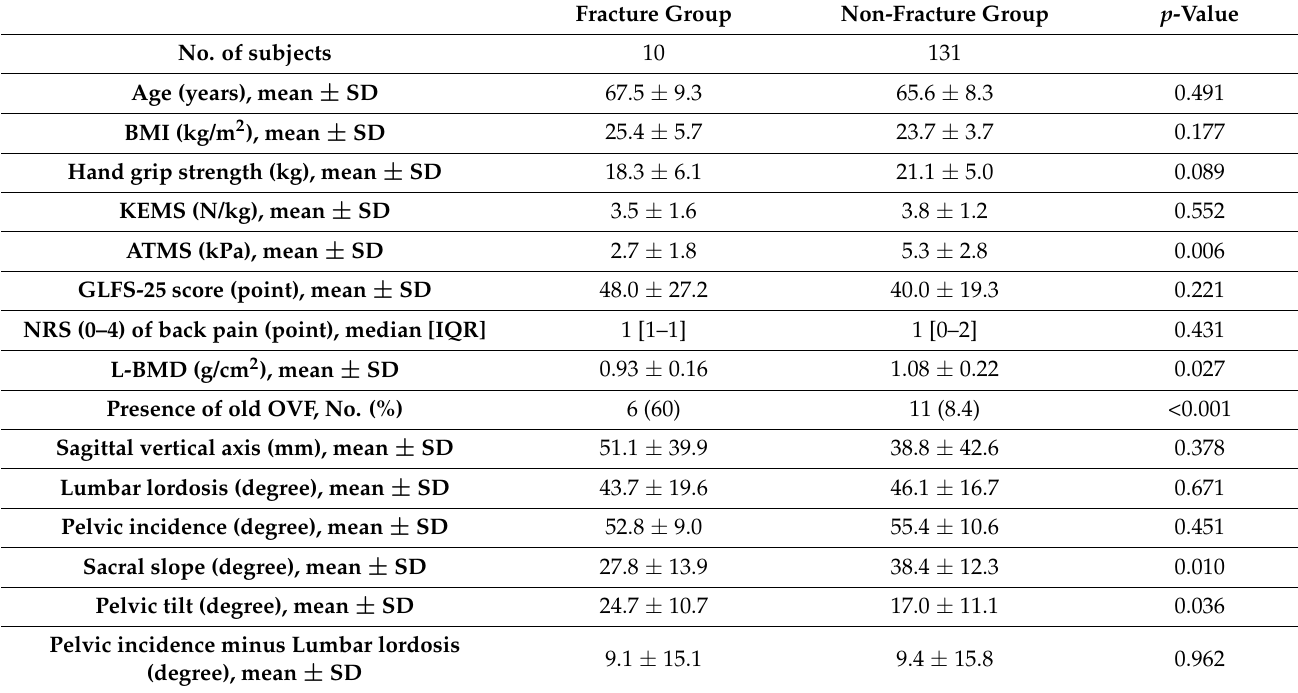
Table 2. Differences in the baseline characteristics between the fracture and non-fracture groups.